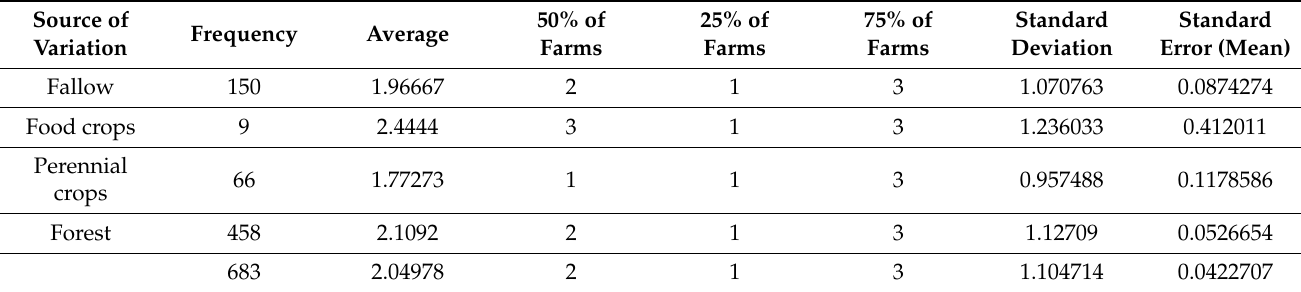
Table 4. Influence of previous land-use systems on the number of tree species that are introduced to cocoa farms in the cocoa-producing zone of C ô te